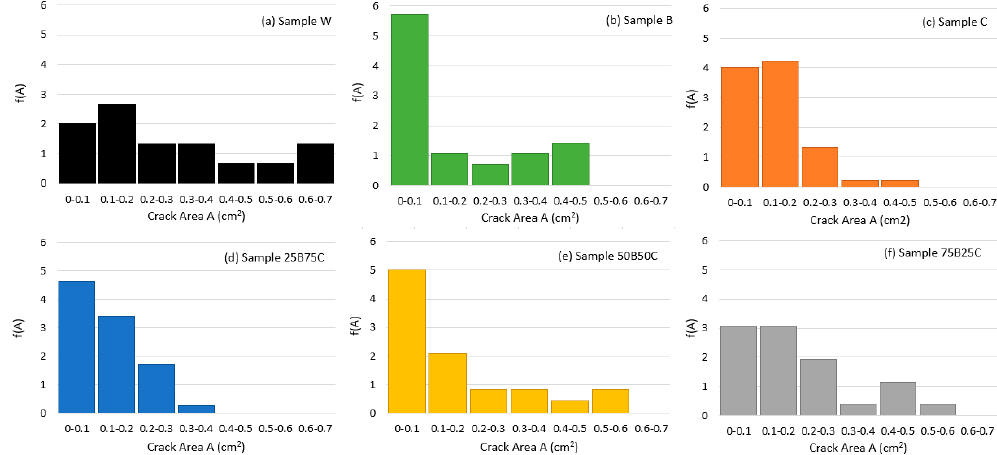
crack width (0.1–0.2 cm). In this study, MPV for crack width is 0.1–0.2 cm for samples B, C, 25B75C, 393 and 50B50C, and 0–0.1 cm for samples W and 75B25C. These probability distribution plots provide a 394 better quantitative overview of the crack pattern. 395 Figure 7. Probability distribution of crack area of four soil samples after 48 h of drying.